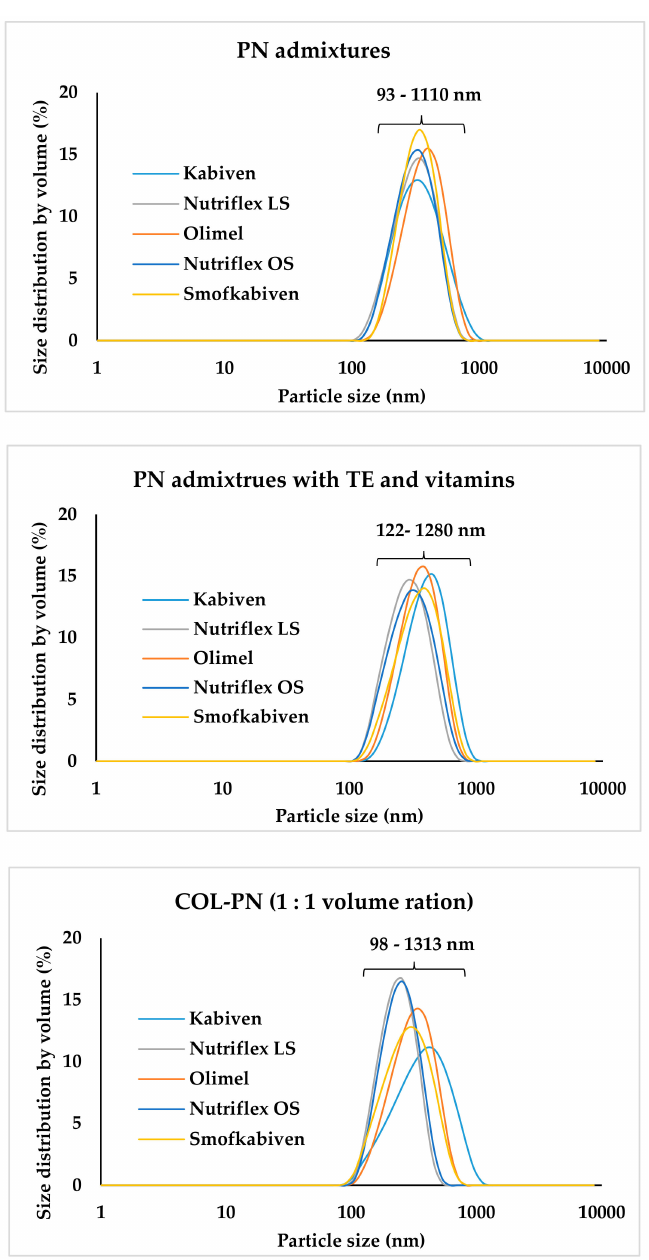
Figure 2. Lipid droplet size distribution by volume for PN admixtures, PN admixtures with TE and vitamins, and COL-PN samples. PN—parenteral nutrition; TE—trace